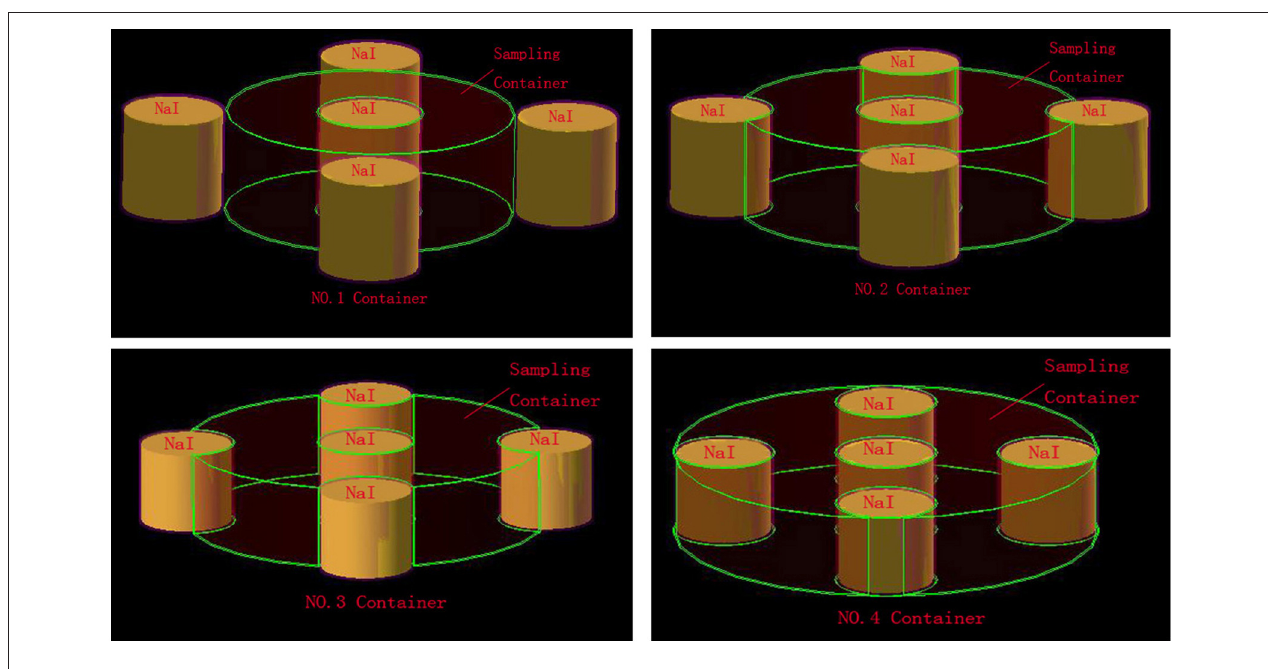
FIGURE 2 | Simulated geometry with GEANT4.